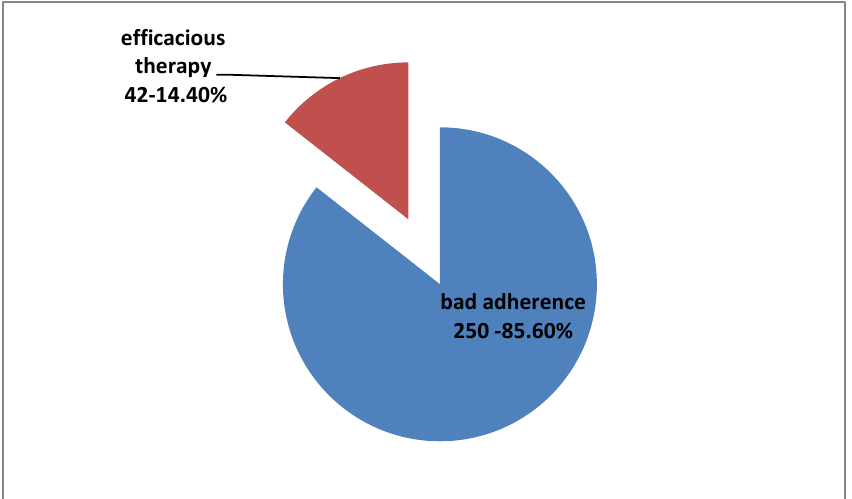
Figure 5. Percentage of bad adherence among 250 patients with no change in therapy disclosed due to IOP phasing procedure.